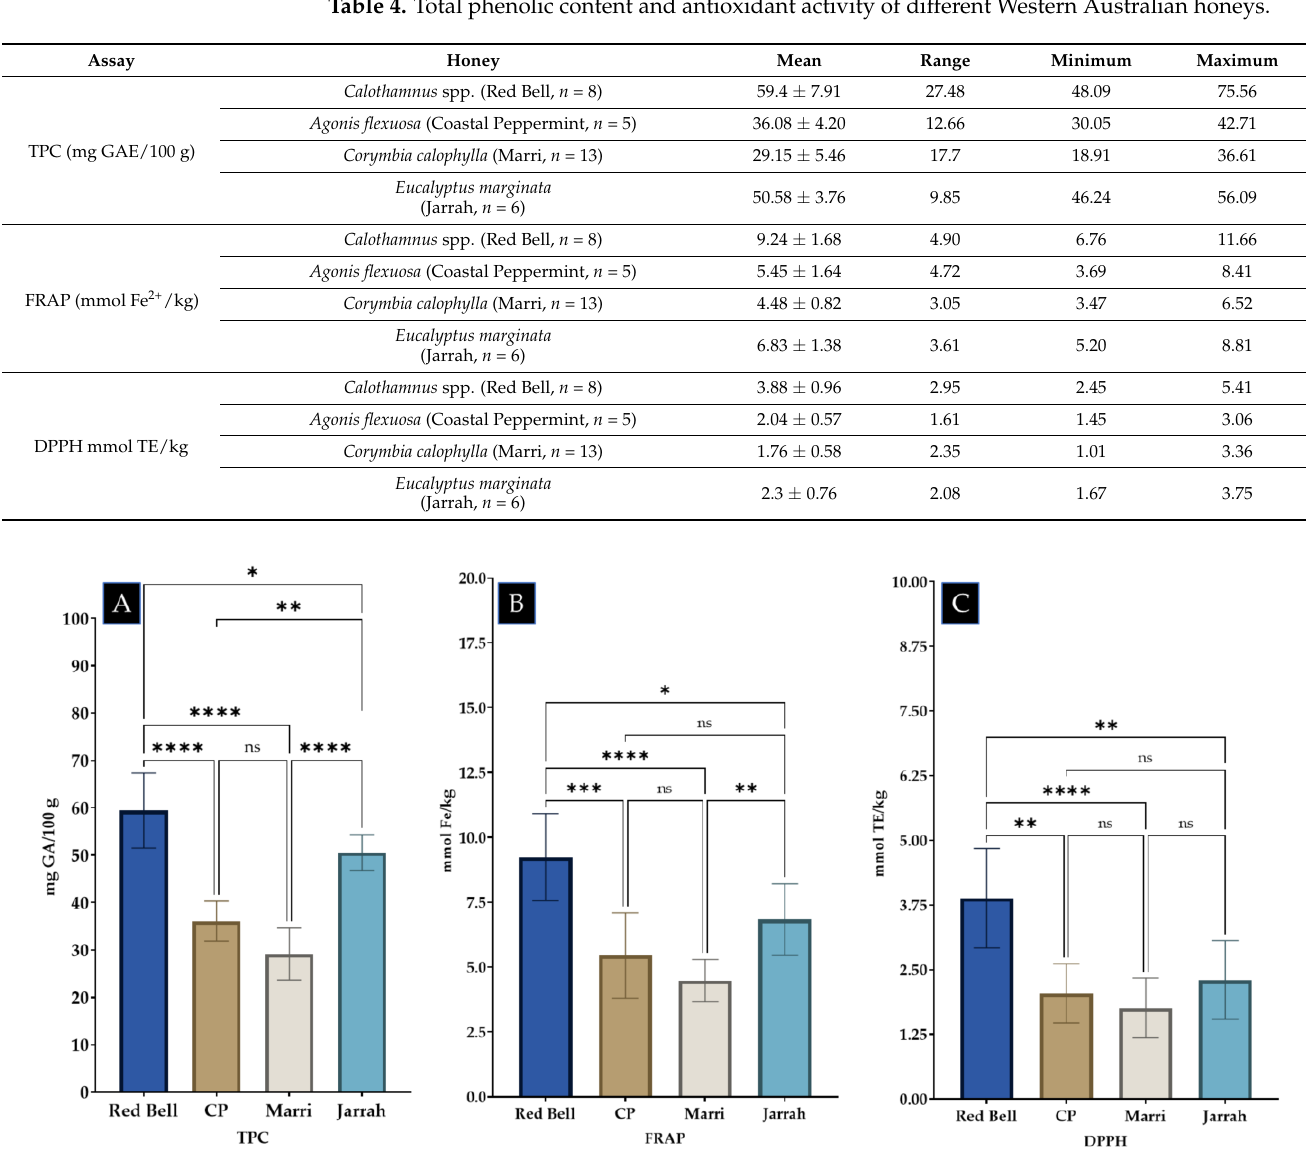
Table 4. Total phenolic content and antioxidant activity of different Western Australian honeys.